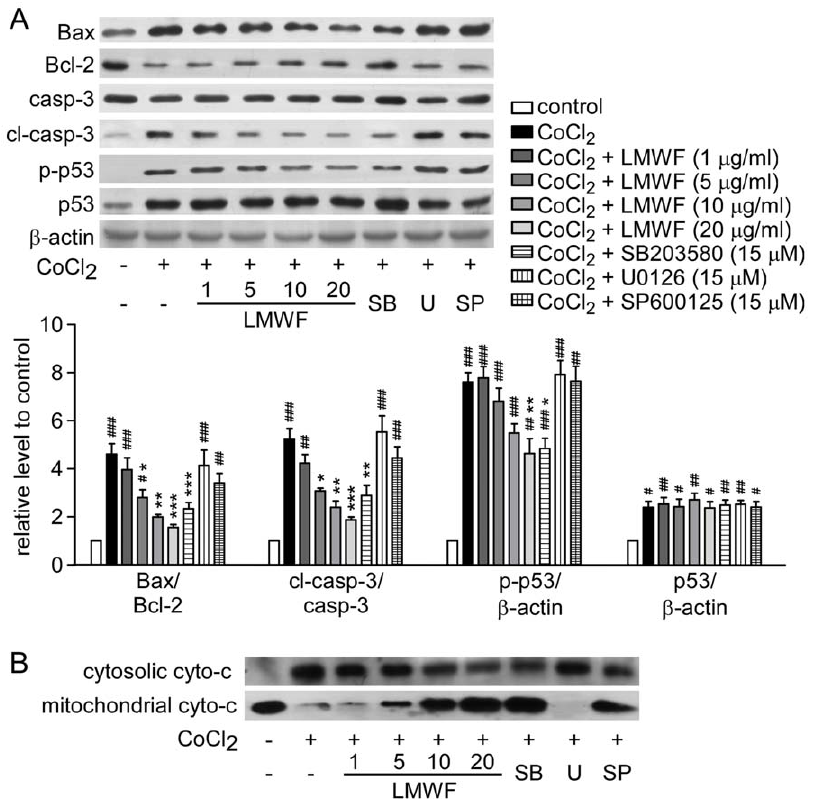
Figure 8. LMWF prevented apoptosis in HK2 cells treated with CoCl 2 . (A) Expression of Bax, Bcl-2, caspase 3, p-p53 and p53 of HK2 cells treated with 600 m M CoCl 2 for 18 h were detected by Western blot analysis. Representative blotting ( up ) and quantification of protein levels ( down ) are shown. Each bar represents the mean 6 SEM. n=3; # P , 0.05, ## P , 0.01, ### P , 0.001 vs. control, * P , 0.05, ** P , 0.01, *** P , 0.001 vs. CoCl 2 treated group. (B) Representative Western blottings of mitochondrial and cytosolic cyto-c are shown.